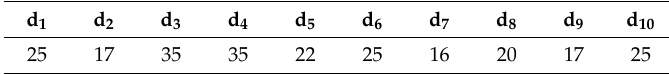
Table 1. Mean demand of urban area.